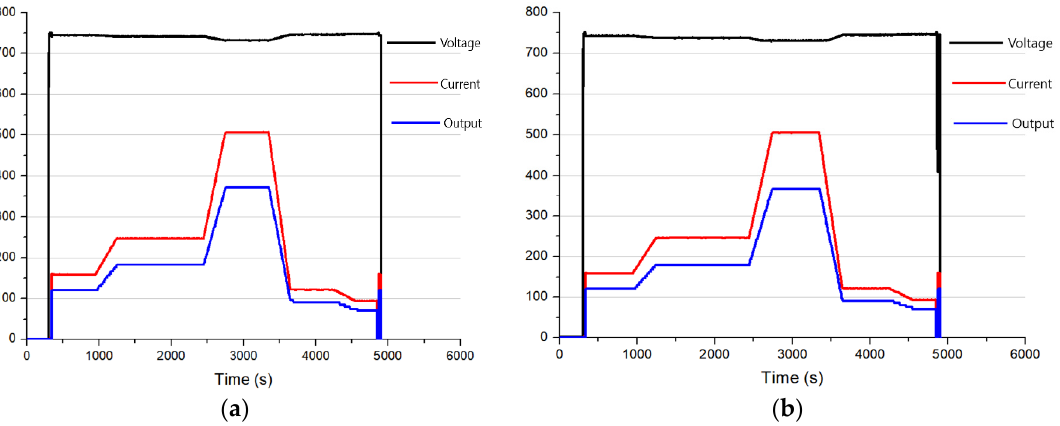
Figure 16. Electric characteristic in voltage, current, and power for the 13K TEU scenario; ( a ) AC grid system (Constant speed mode), ( b ) DC grid system (Variable speed